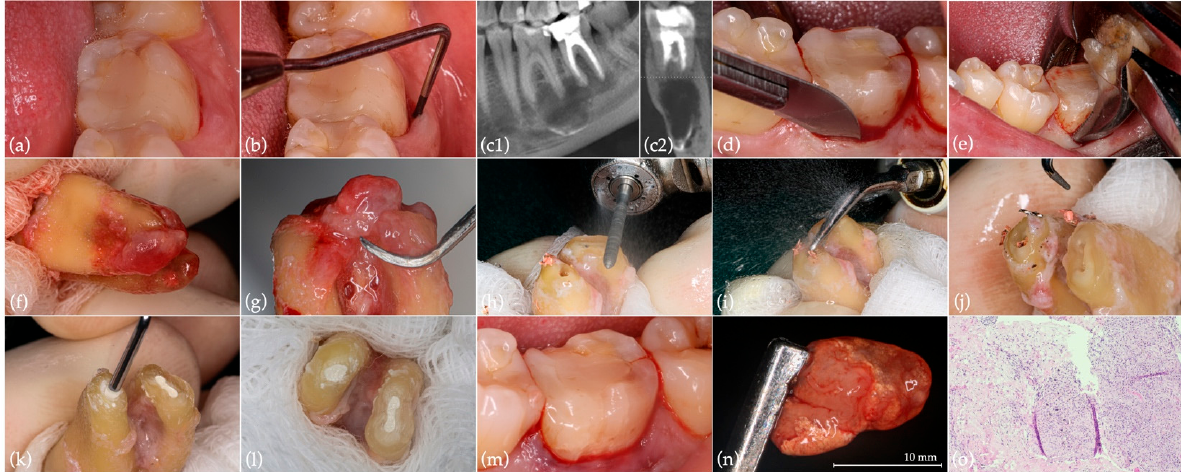
Figure 1. Preoperative situation and IR of tooth 37: ( a ) initial situation; ( b ) mid-buccal probing pocket depth (9 mm); ( c1 ) sagittal and ( c2 ) coronal CBCT section of the region of interest; ( d ) periodontal fiber separation; ( e ) atraumatic extraction with dental forceps; ( f ) meticulous inspection of the root surface; ( g ) granulation tissue removal using periodontal scalers; ( h ) root resection; ( i ) root-end ultrasonic preparation; ( j ) fractured instrument removal; ( k ) root-end filling with Biodentine; ( l ) final aspect of the root-filled apical cavities, with evident isthmus in the mesial root; ( m ) tooth replanted in the previously prepared alveolus (by a thorough sterile saline solution rinsing and periapical lesion and extruded filling material removal), without splinting; ( n ) removed large periapical lesion; ( o ) histological section of the removed periapical lesion showing granulation tissue with abundant inflammatory infiltrate and exogenous material (hematoxylin and eosin staining, 200× magnification). 2.1. Intentional Replantation Preoperative antisepsis of the oral cavity (0.2% chlorhexidine digluconate solution rinse for 1 min) and infiltrative anesthesia (2% lidocaine with 1:80.000 epinephrine) were carried out. After separating the periodontal fibers through an intrasulcular incision parallel to the tooth’s long axis with a 12-blade surgical scalpel (Figure 1d), atraumatic extraction by exerting a controlled force with dental forceps was carried out (Figure 1e). Extra-oral handling started with meticulous root surface inspection (Figure 1f) and granulation tissue removal (Figure 1g) while wrapping the tooth’s crown in saline-soaked gauze. An apicoectomy (3 mm), perpendicular to the tooth’s long axis, was performed with a high-speed truncated-conical diamond bur (FG ML 200651AA, ISO 290012, Diatech; Coltène/Whaledent, Altstätten, Switzerland) under continuous water spray (Figure 1h), followed by 3 mm deep apical preparation using ultrasonic tips (E32D; NSK, Tochigi, Japan) (Figure 1i), with the removal of the fractured instrument (Figure 1j). Subsequently, the apical cavity was dried and filled with Biodentine (Septodont, Saint- Maur-des-Fossés Cedex, France) (Figure 1k,l). Extra-oral procedures were completed in 17 min under 10× magnification (Leica Microscope M320; Leica Microsystems, Heerbrugg, Switzerland). While tooth extraoral handling procedures were being performed, the alveolus was prepared under 6× magnification. Alveolus preparation included careful and meticulous curettage, using a surgical curette for periapical lesions and extruded filling material removal, in alternation with thorough sterile saline solution rinsing. The tooth was then replanted in the previously prepared alveolus (Figure 1m) and the patient was instructed to bite on gauze. No splinting was required, as primary stability was confirmed. Both extra-oral handling and alveolus preparation procedures were performed by two experienced operators (J.M.S. and P.J.P., respectively) in order to reduce operative time. An anatomopathological analysis of the removed periapical lesion identified a chronic